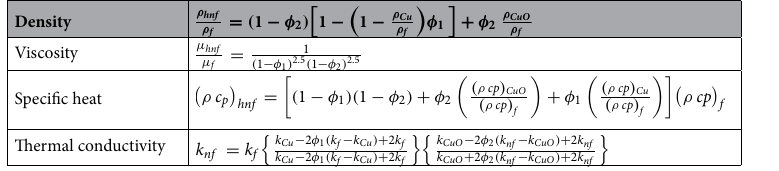
Table 3. The following model is considered for Cu + CuO / blood hybrid nanoliquid 15,27 .